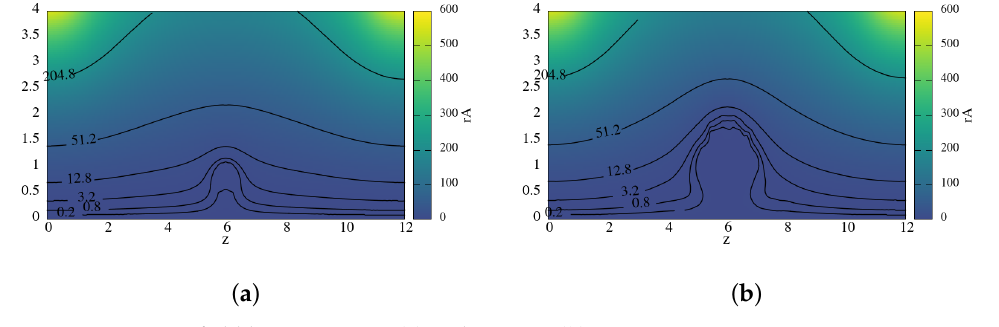
Figure 2. Magnetic field lines at T = 20 ( a ) and T = 120 ( b